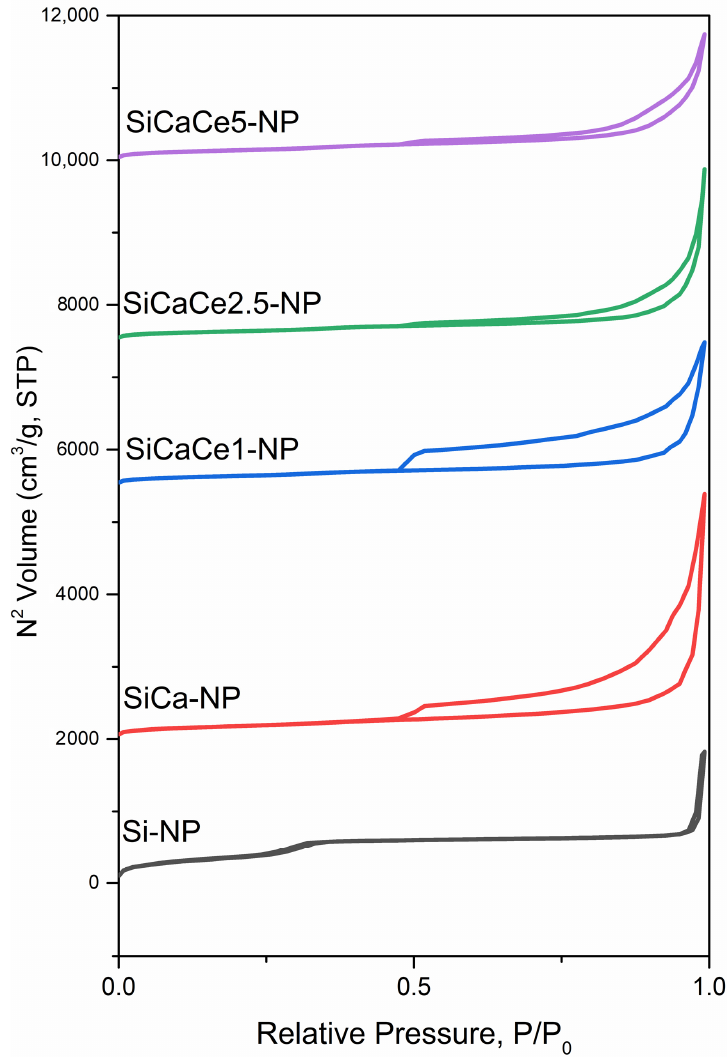
Figure 4. N 2 adsorption-desorption isotherms of